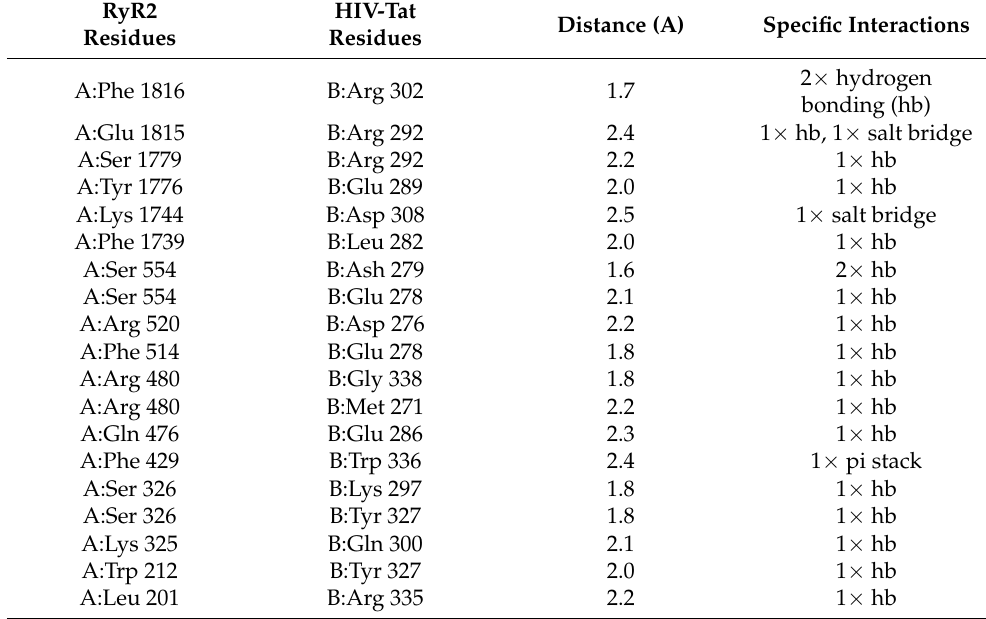
Table 3. Thermodynamically favored Interactions between RyR2 and HIV-Tat at site